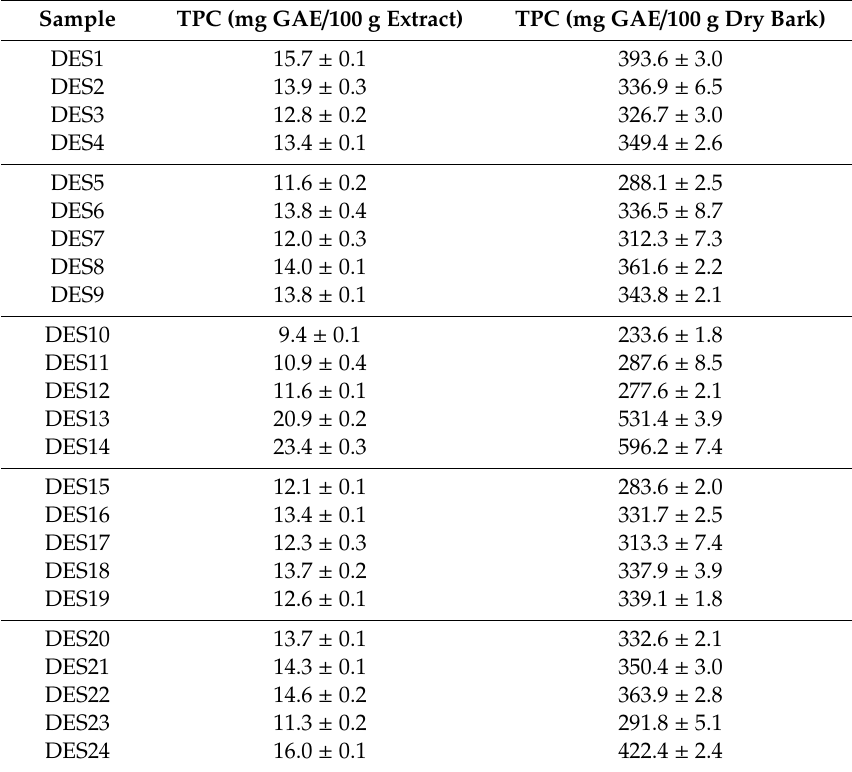
Table 5. Total phenolic contents of the spruce bark extracts obtained with